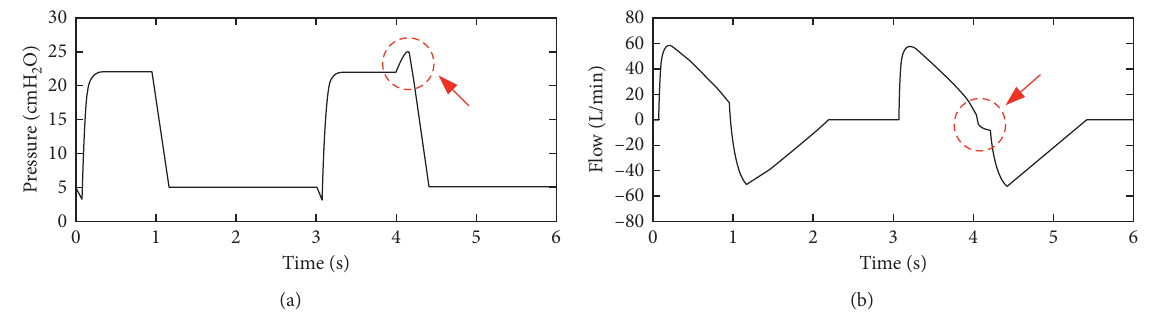
Figure 10: Ventilator waveforms of delayed